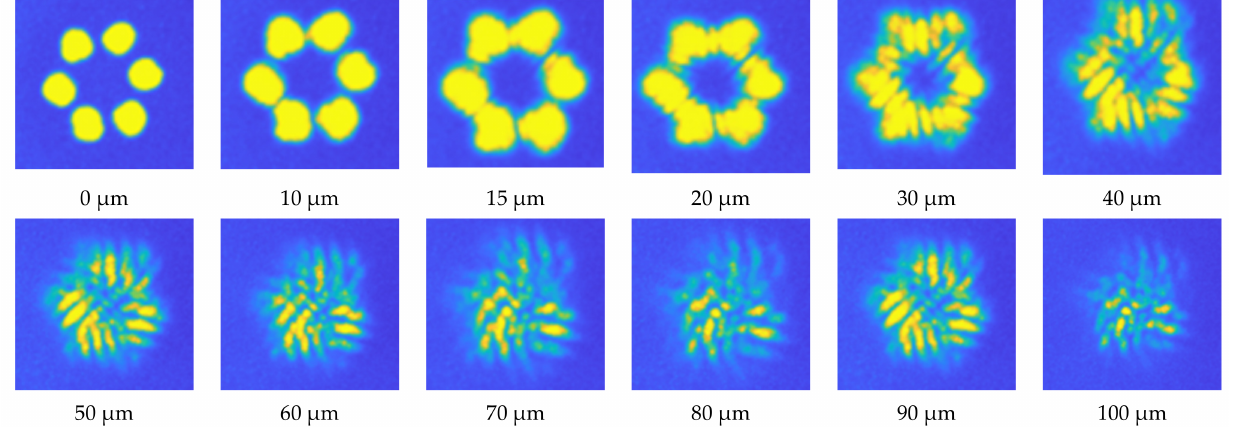
Figure 17. Dynamics of laser beam profile pattern, measured at the receiving end after propagation over 5 m long 100 rpm twisted graded-index six-core-MOF, connected to BLD source ( λ = 1550 nm) via SMF OFL conditions over the researched range of distances between the MOF receiving end and the IR-camera objective of 0 . . . 100 µ m.